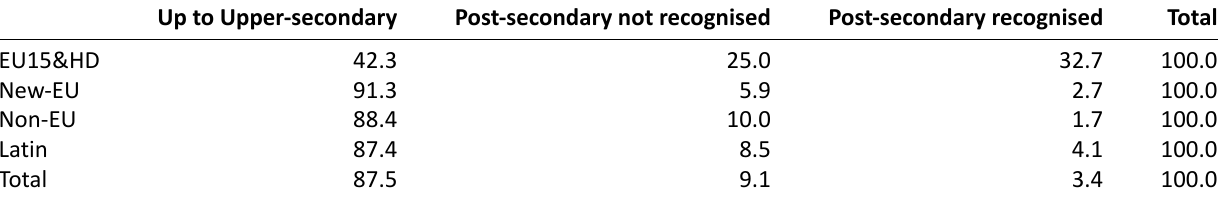
Table A3. Descriptive statistics for the interaction term in Figure 4 (area of origin ## education at